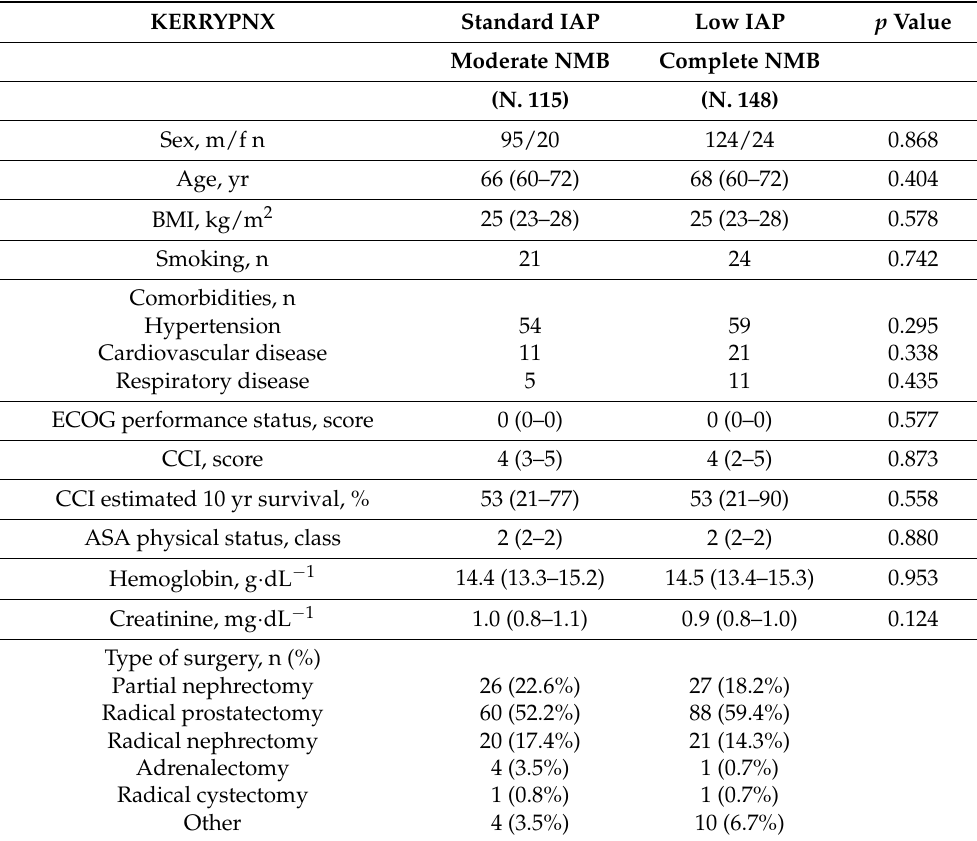
Table 2. Baseline characteristics of patients and pre-operative